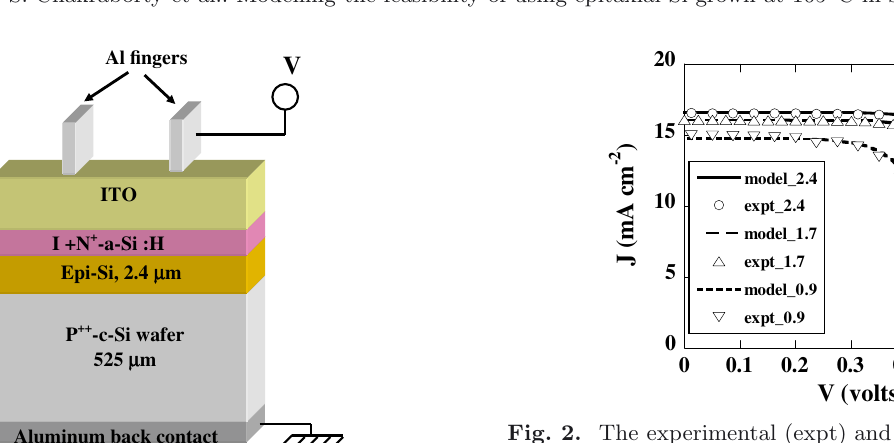
Fig. 2. The experimental (expt) and simulated (model) illu- minated J - V characteristics of the epi-Si NIP cells, where the thickness of the epi-Si layer is 2.4 μ m, 1.7 μ m and 0.9 μ m. 00.20.40.60.81